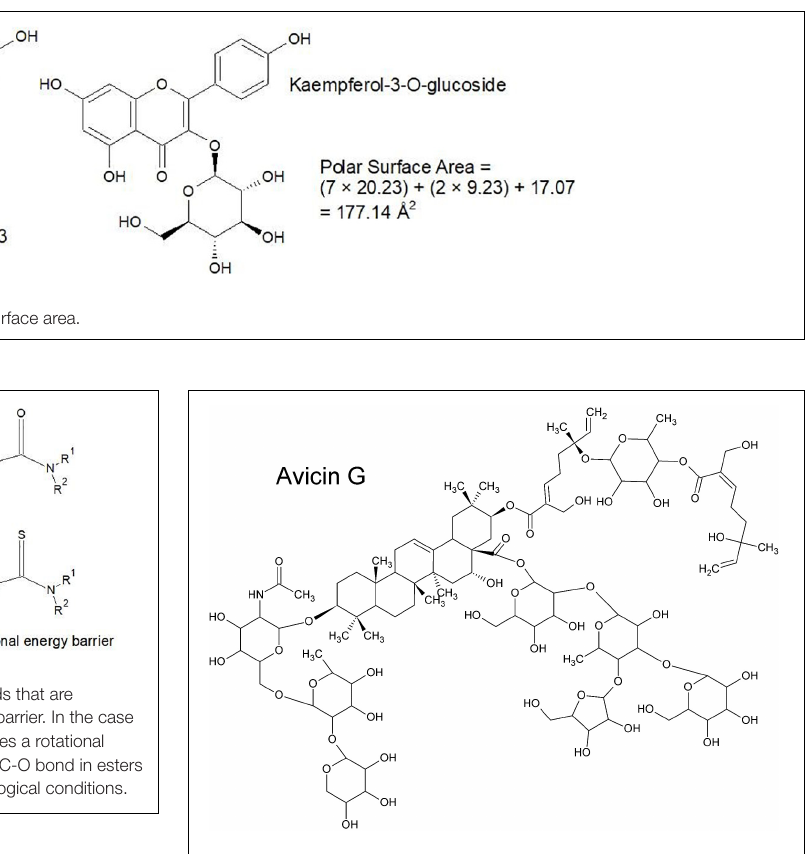
FIGURE 7 | Avicin G (Pino et al., 2012). Despite its large size and the presence of strongly polar functional groups, Avicin G passes epidermal layers as effectively as smaller lipophilic molecules. The steric balance of lipophilic and hydrophilic moieties and the acetamide group is key to the saponin’s transdermal penetrative